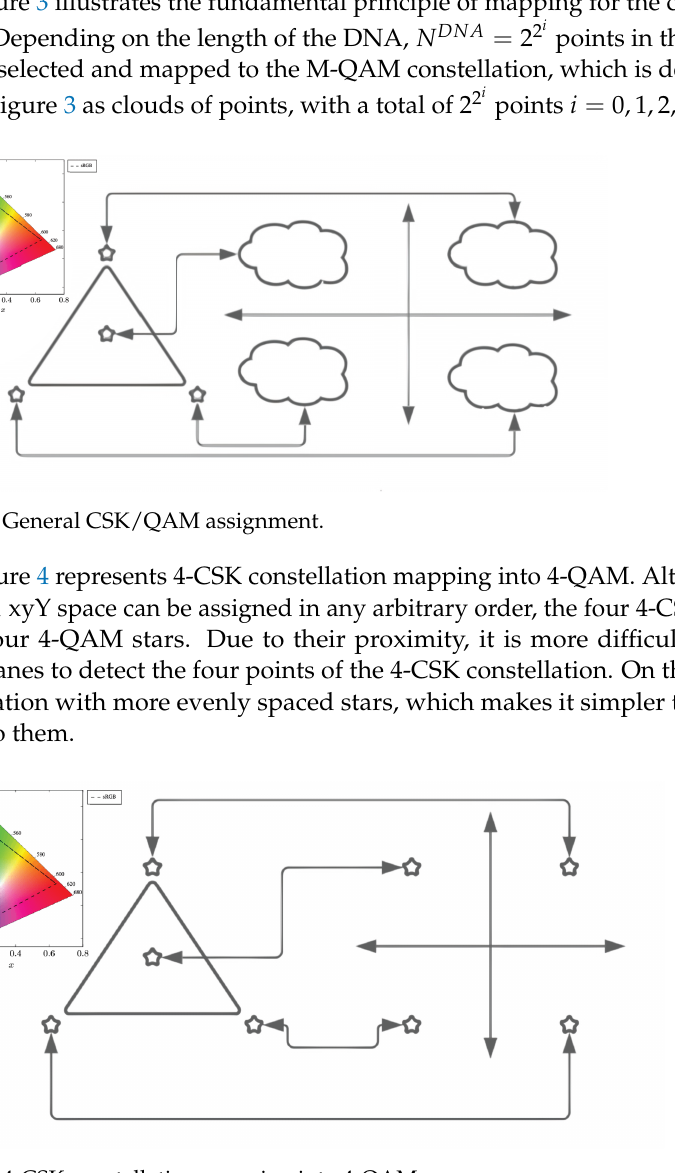
Figure 4. 4-CSK constellation mapping into